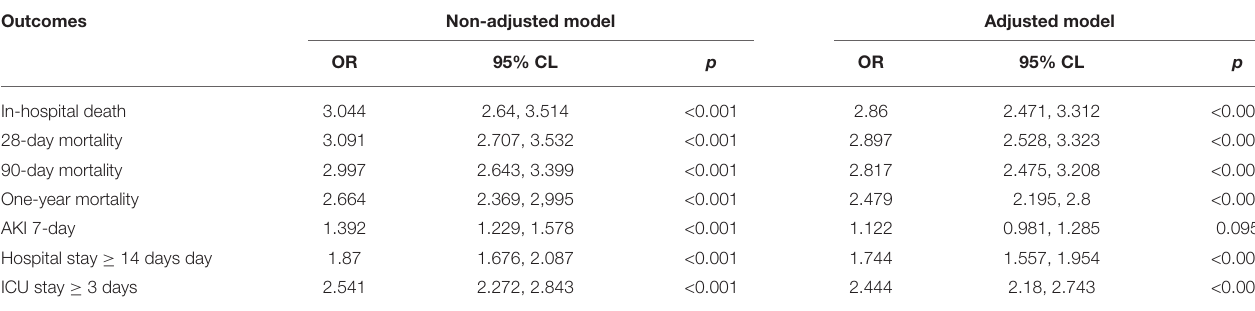
TABLE 3 | The logistics regression of SOFA scoring